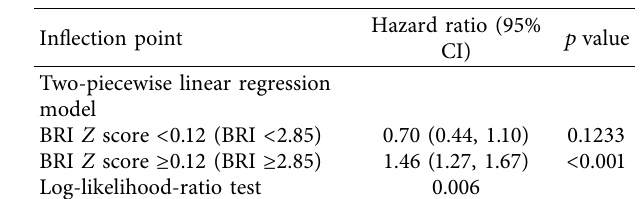
Table 3: Threshold effect analysis of BRI for incident T2DM in men in the NAGALA